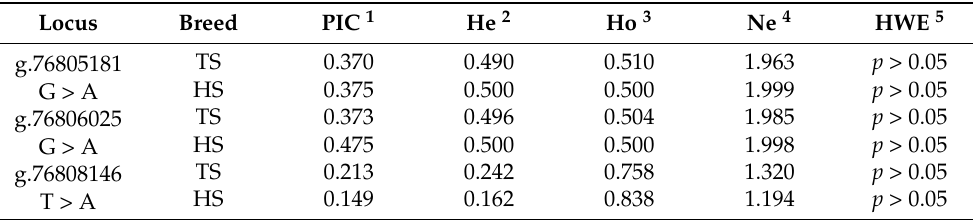
Table 3. Population genetics analysis of three positions of HIF-1 α gene in Tibetan sheep (TS) and Hu sheep (HS).